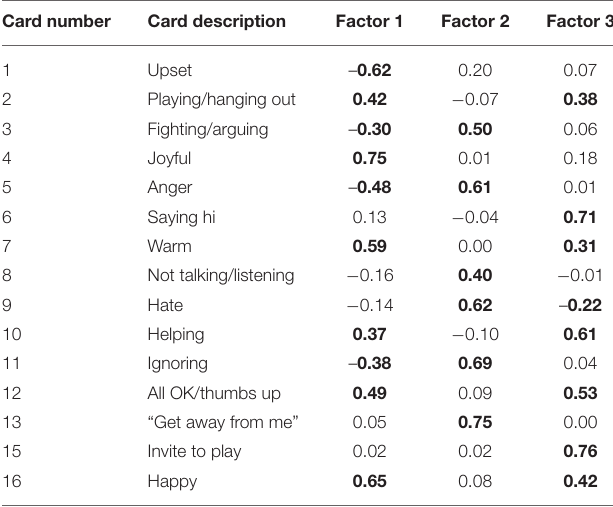
TABLE 4 | Factor loadings exploratory bi-factor solution of fifteen items for the Line Task (maximum pairwise N = 154) (Study 2). Card